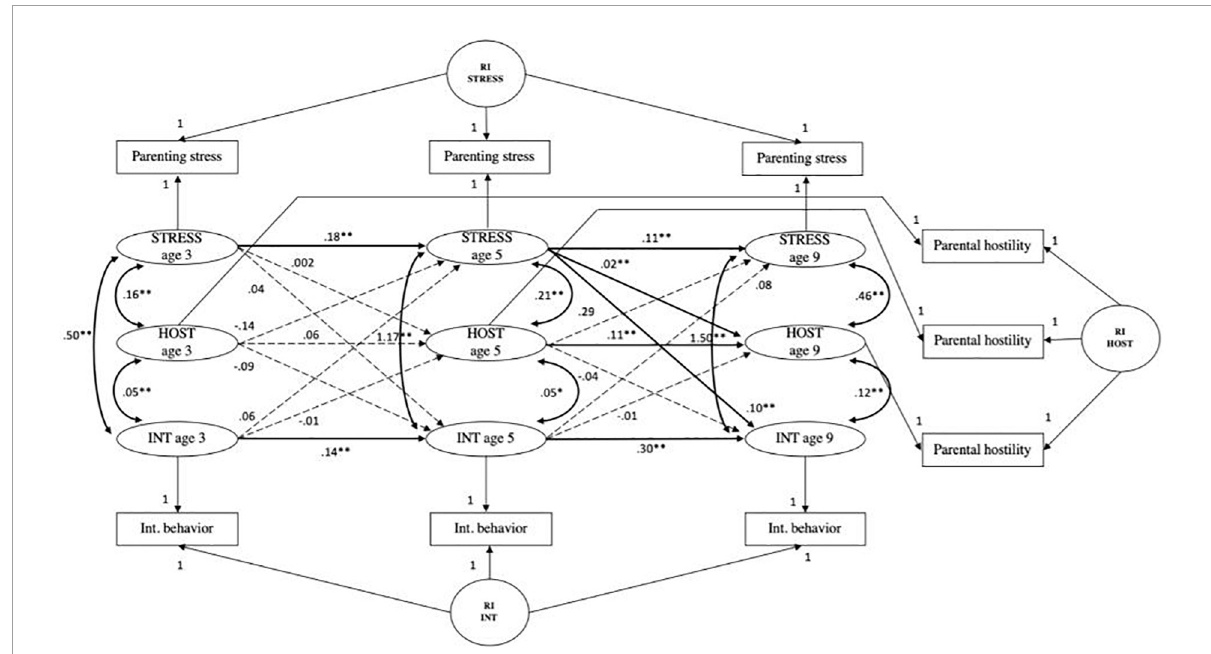
FIGURE3 Random intercepts cross-lagged panel model showing relations among parenting stress (STRESS), parental hostility (HOST) and child internalizing behaviors (INT) across three waves. Age 3, wave 2; age 5, wave 3; age 9, wave 5; R, residual variance; RI INT, random intercept child internalizing behavior; RI STRESS, random intercept parenting stress; RI HOST, random intercept parental hostility. Standardized estimates reported. Gray dashed paths indicated non-significant estimates. ∗ p < 0.01, ∗∗ p < 0.001.